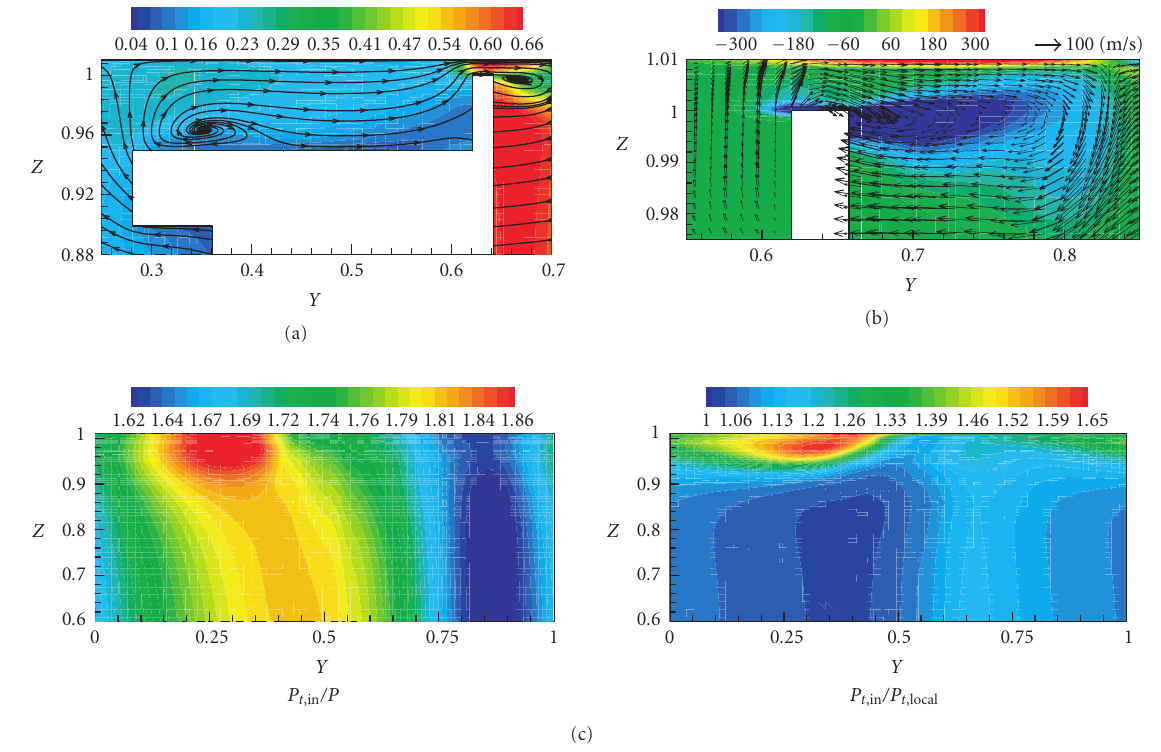
Figure 19: (a) Secondary flow distribution superimposed on the Mach number contour at a streamwise location of 40% from leading wall of the blade, (b) tip leakage secondary vortices at a streamwise location of 60% from the leading edge of the blade, and (c) contours of the pressure ratio ( P t ,in /P ) and P t ,in /P t ,local at a streamwise location of 120% from the leading edge of the blade.